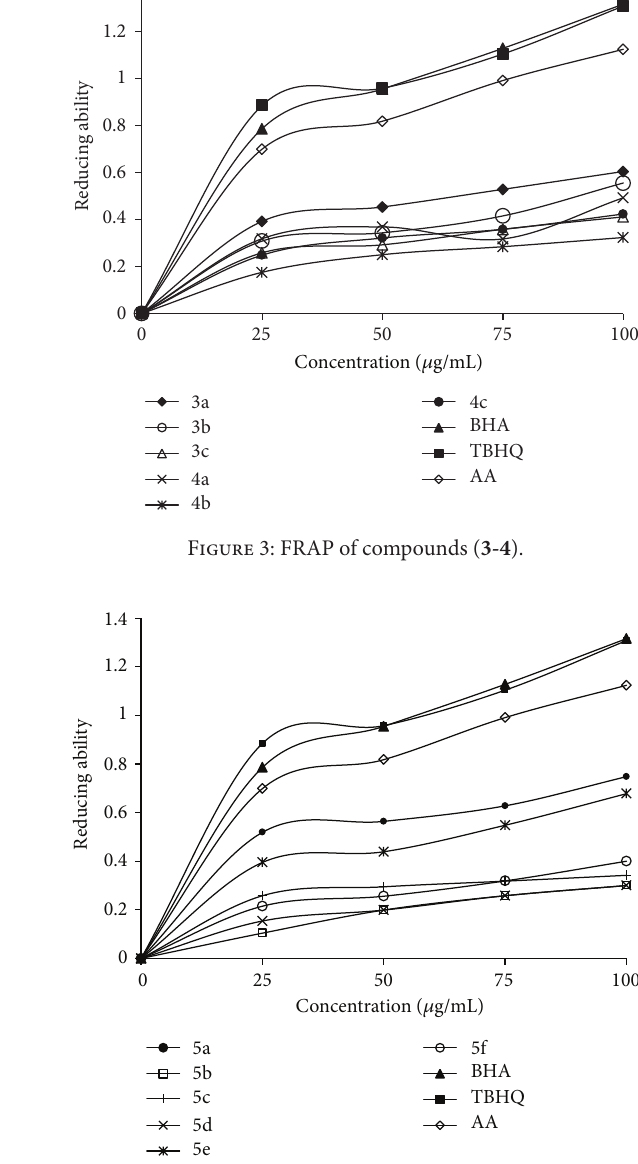
F 2: Radical scavenging activity of compounds ( 5 ).